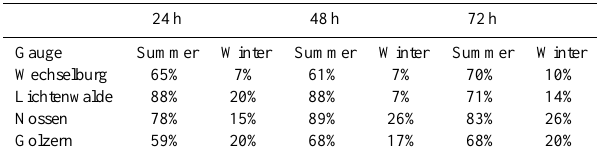
Table 5. Percentages of agreement between precipitation AMS (precipitation sums of 24h, 48h and 72h) and discharge